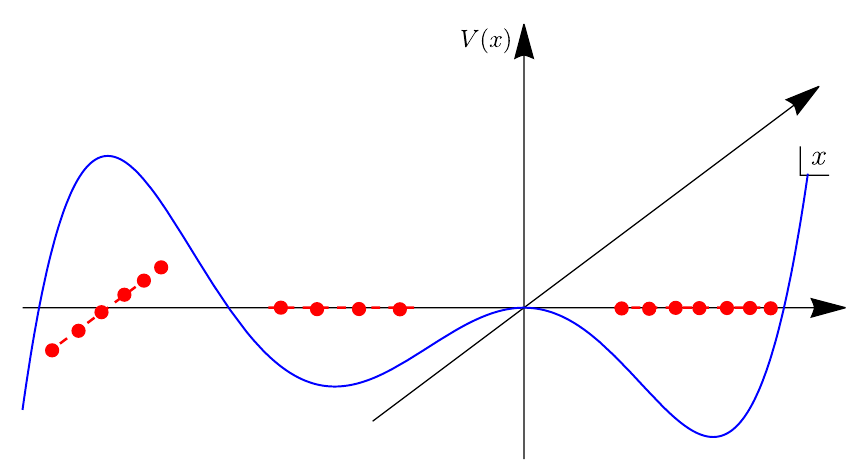
Figure 1 . Coulomb gas interpretation for the eigenvalue configurations and a typical cut configu- ration. For a general solution of the SDP (2.15), we can have a complex cut at the maximum of the